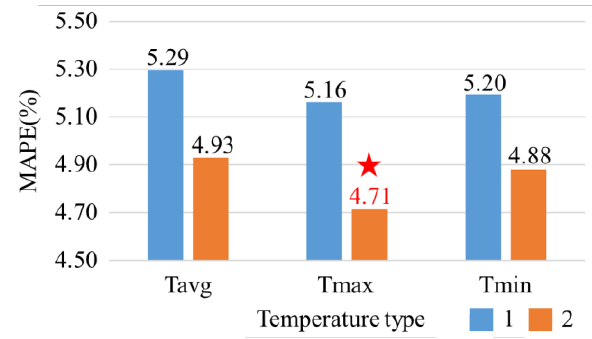
Figure 6 MAPE values of the six LSTM